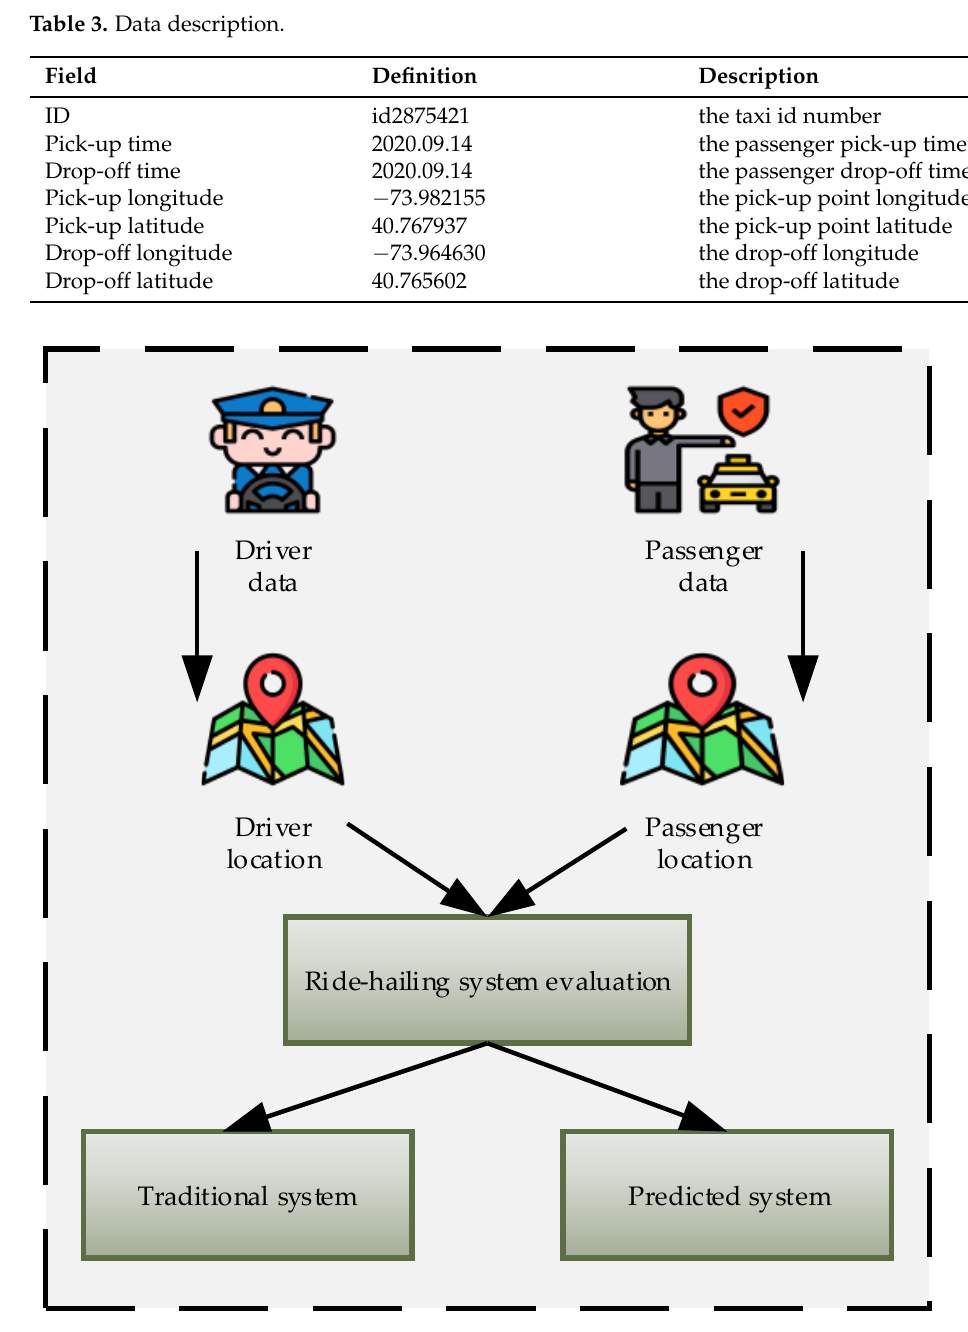
Figure 11. Input and output data